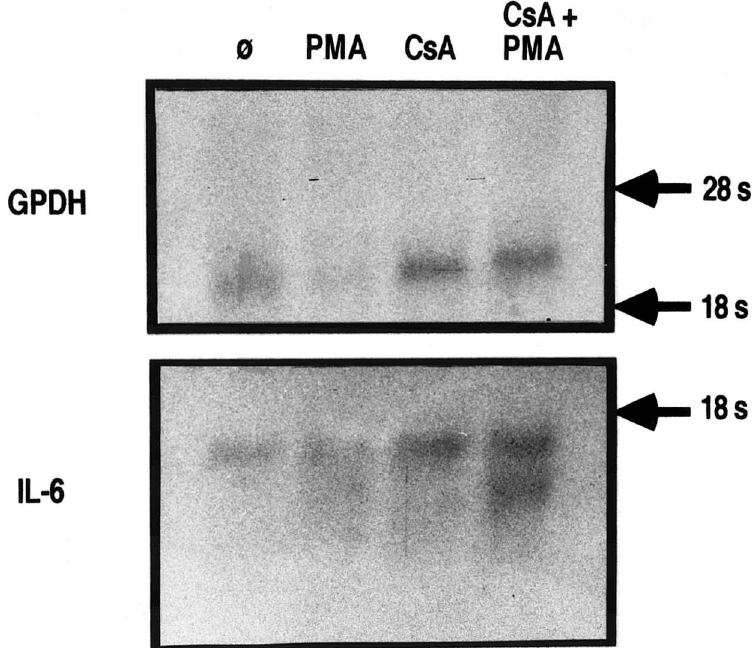
FIG. 3. Effect of CsA on IL-6 mRNA expression. Study of the action of CsA on IL-6 mRNA expression by Northern blot was carried out on the differentiated cell line under both basal and stimulated conditions. As seen, CsA did not affect IL-6 mRNA levels under either basal or stimulated conditions. Definition of abbreviations: CsA, cyclosporin A; GPDH, glyceraldehyde phosphate dehydrogenase; IL-6 interleukin-6; PMA, phorbol myristate